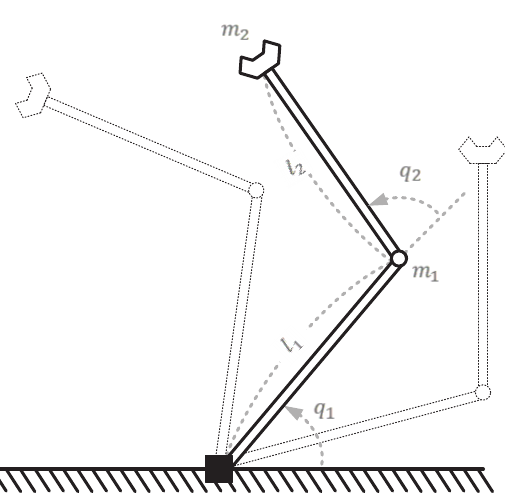
Figure 2. A 2-link planar robot